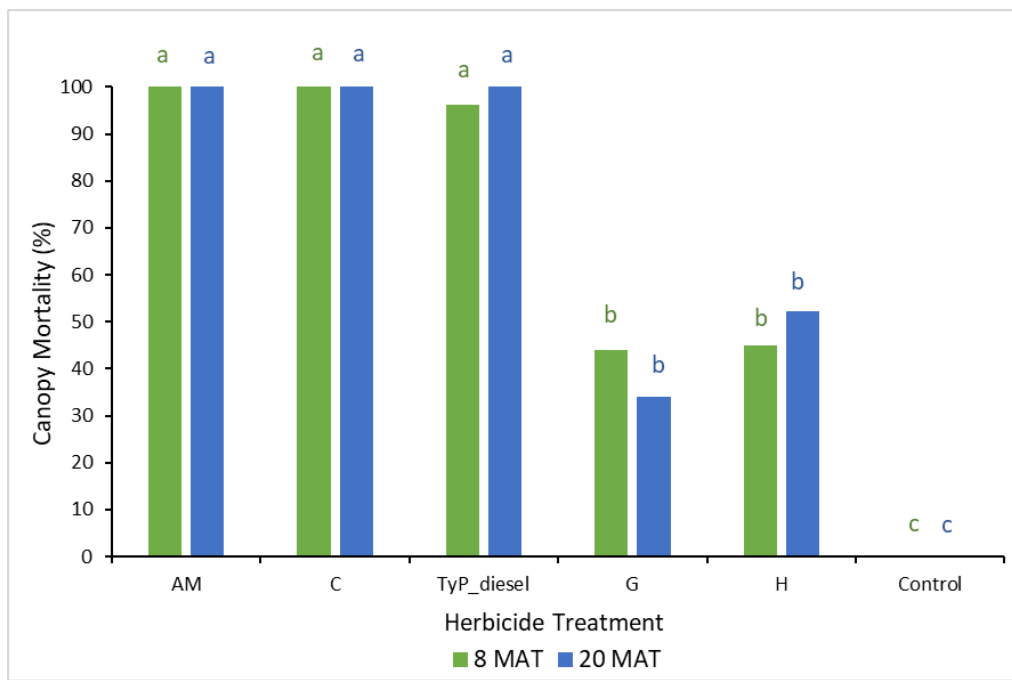
Figure 6. Mimosa bush canopy mortality 8 and 20 MAT following herbicide applications to intact plants in trial 2. AM, aminopyralid + metsulfuron-methyl; C, clopyralid; TyP_diesel, triclopyr + picloram mixed with diesel; G, glyphosate; H, hexazinone. For each monitoring time, columns with different letters indicate significant difference by Tukey’s test with 95% confidence.